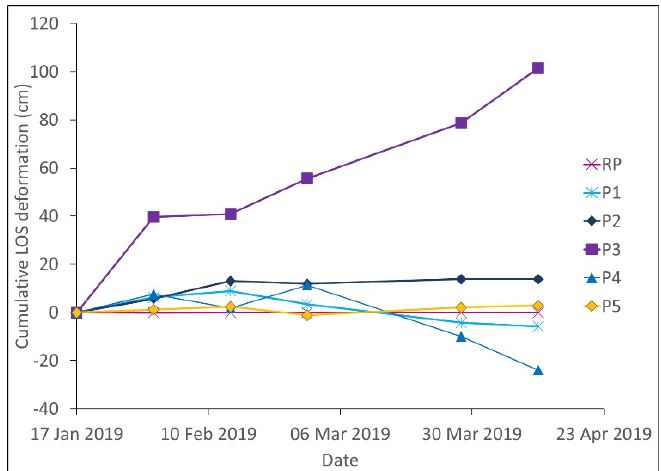
Figure 7. ALOS-2 (Descending mode) InSAR cumulative LOS deformation (relative deformation between the first date and subsequent dates) from HH polarization (+ for movement toward sensor, − for movement away from sensor).